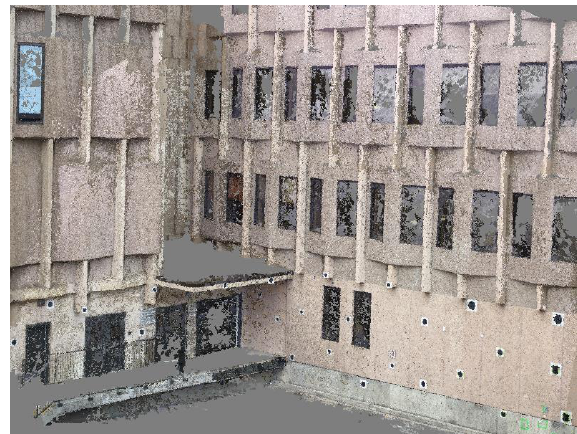
Figure10. Image-based 3D point cloud